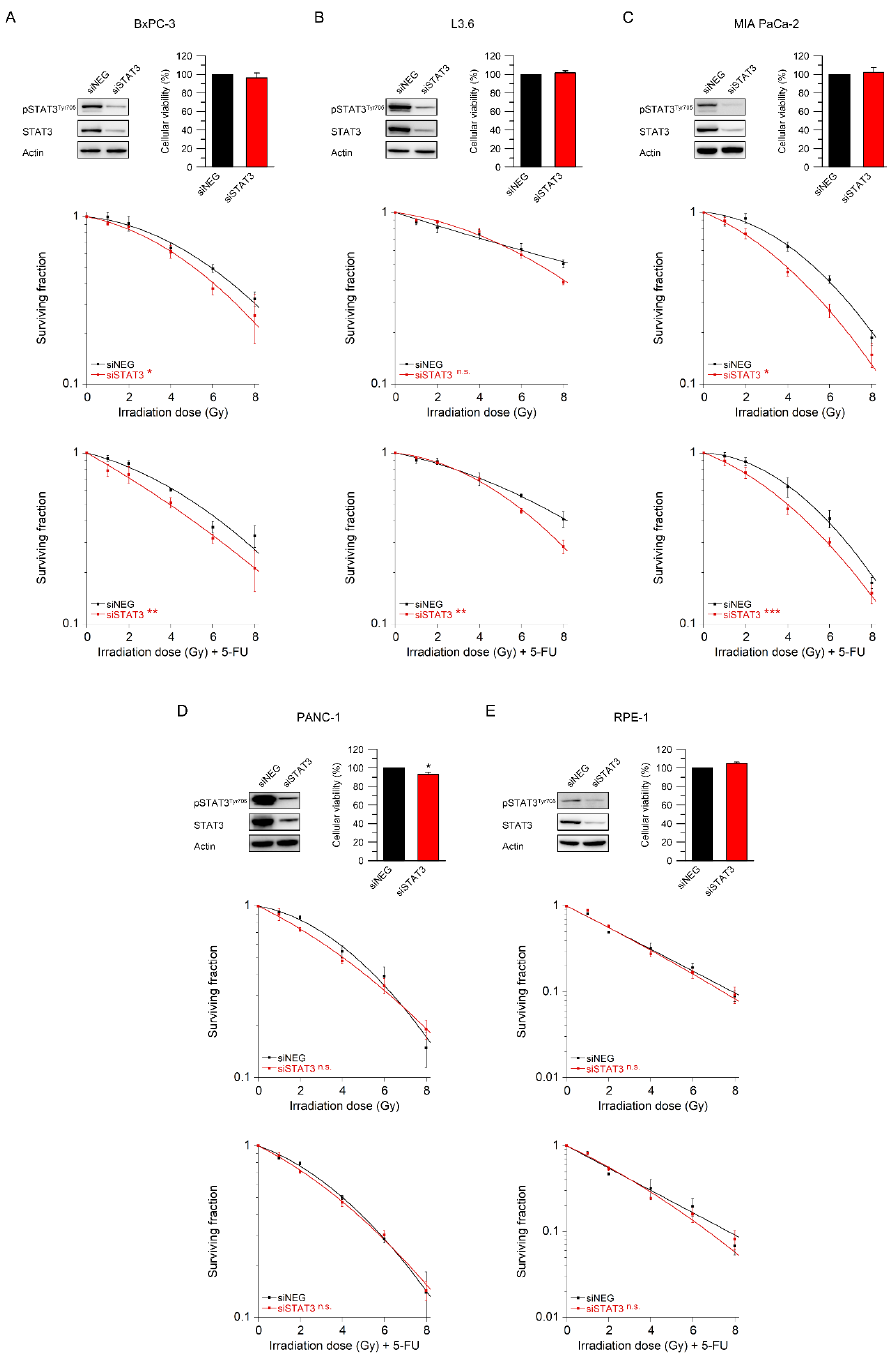
Figure 3. Sensitization to radiotherapy and chemoradiotherapy depends on IL-6/STAT3 pathway activity. ( A – E ) STAT3-active cell lines BxPC-3 ( A ), L3.6 ( B ), and MIA PaCa-2 ( C ); the STAT3-inactive cell line PANC-1 ( D ); and the normal retinal epithelial cell line RPE-1 ( E ) were transfected with control siRNA (siNEG) or an siRNA pool targeting STAT3, and, after stimulation with 100 ng/mL IL-6, subjected to immunoblot analyses (upper left) or cellular viability assays (upper right). Following siRNA-mediated STAT3 silencing, cells were monitored for CFA survival after irradiation alone (middle panel) or RT in the presence of 5-FU (CRT) (lower graph). Data are presented as mean ± s.e.m. from at least 3 independent biological replicates. * p < 0.05, ** p < 0.01, *** p < 0.001, unpaired two- sample Student’s t -test or two-way analysis of variance (ANOVA). For p -values, see Table